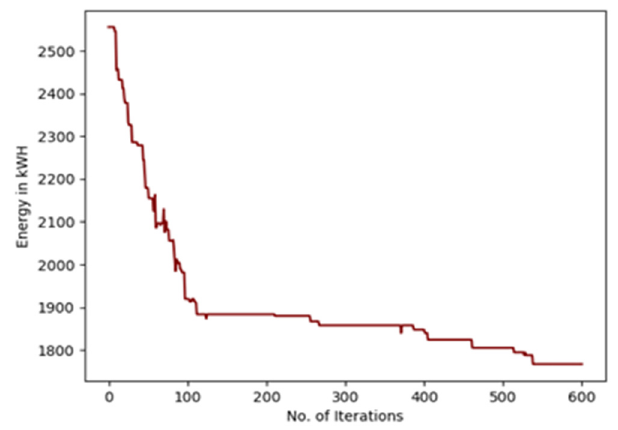
Figure 3. Total energy consumed by the three trucks (GA).